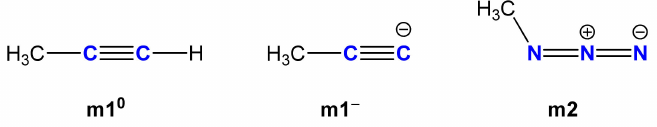
Figure 2. Structure of model alkyne and azide studied